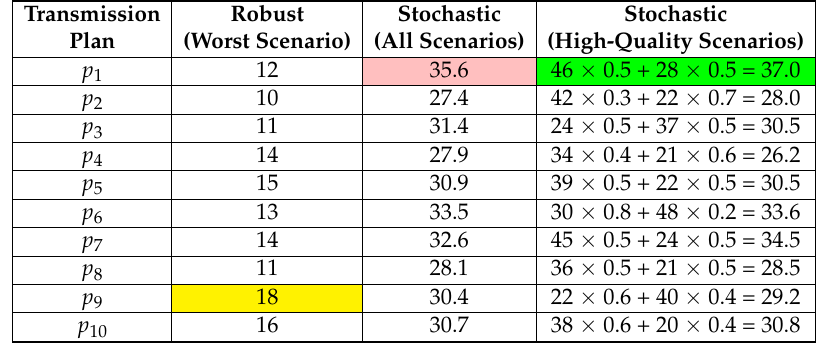
Table 3. Optimal solutions using robust TEP under the worst case scenario, stochastic TEP with all 10 scenarios, and stochastic TEP under 2 high-quality scenarios. Assuming equal likelihood for the 10 scenarios, we calculate the probabilities of the two high-quality ones as the percentages of scenarios that are better represented by the scenarios. Take plan p 2 for example; s 7 represents three higher welfare scenarios ( s 4 , s 5 , and s 7 itself), and s 9 represents the other seven lower welfare scenarios, so 0.3 and 0.7 are used for their respective probabilities for the forth column in the